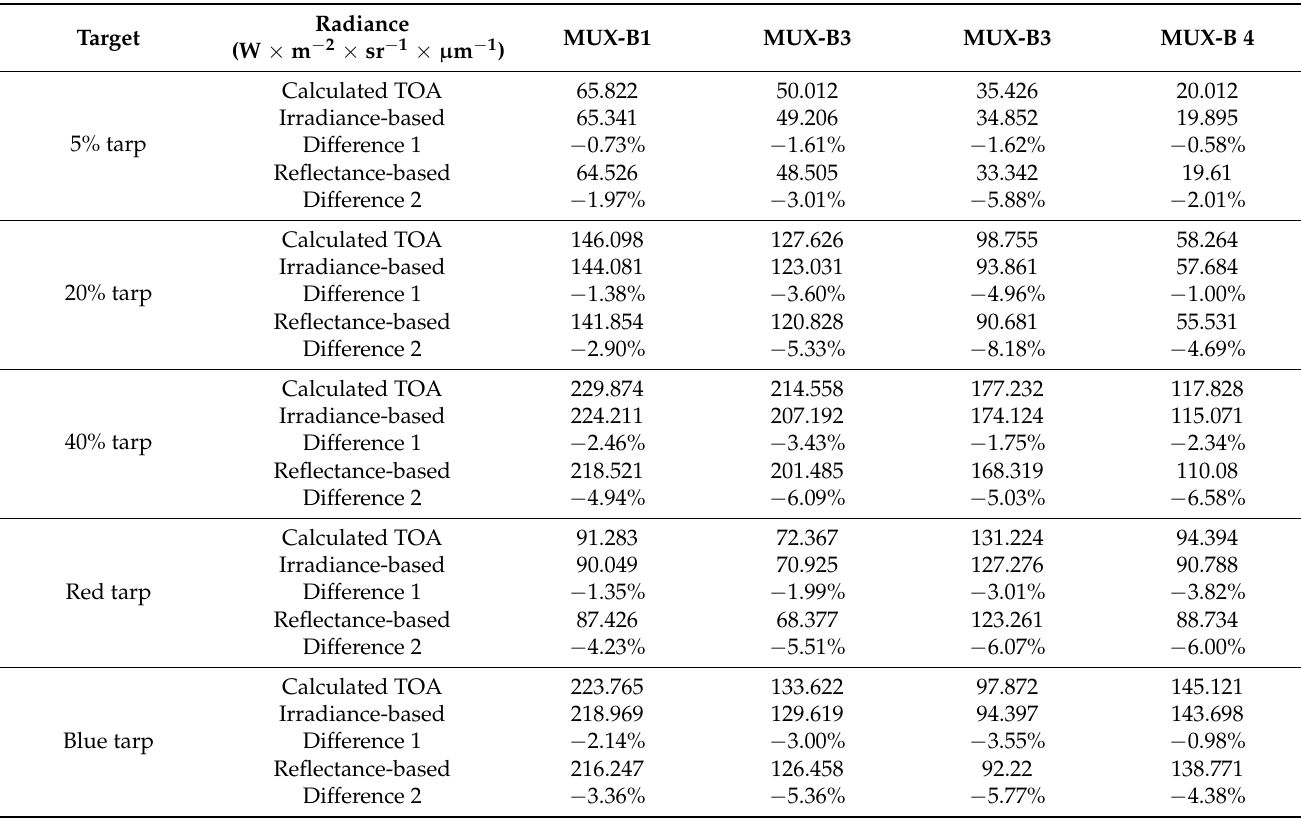
Table 8. Difference between the TOA radiance predicted by calibration methods and the calculated TOA radiance using official calibration coefficient (3 July 2018).